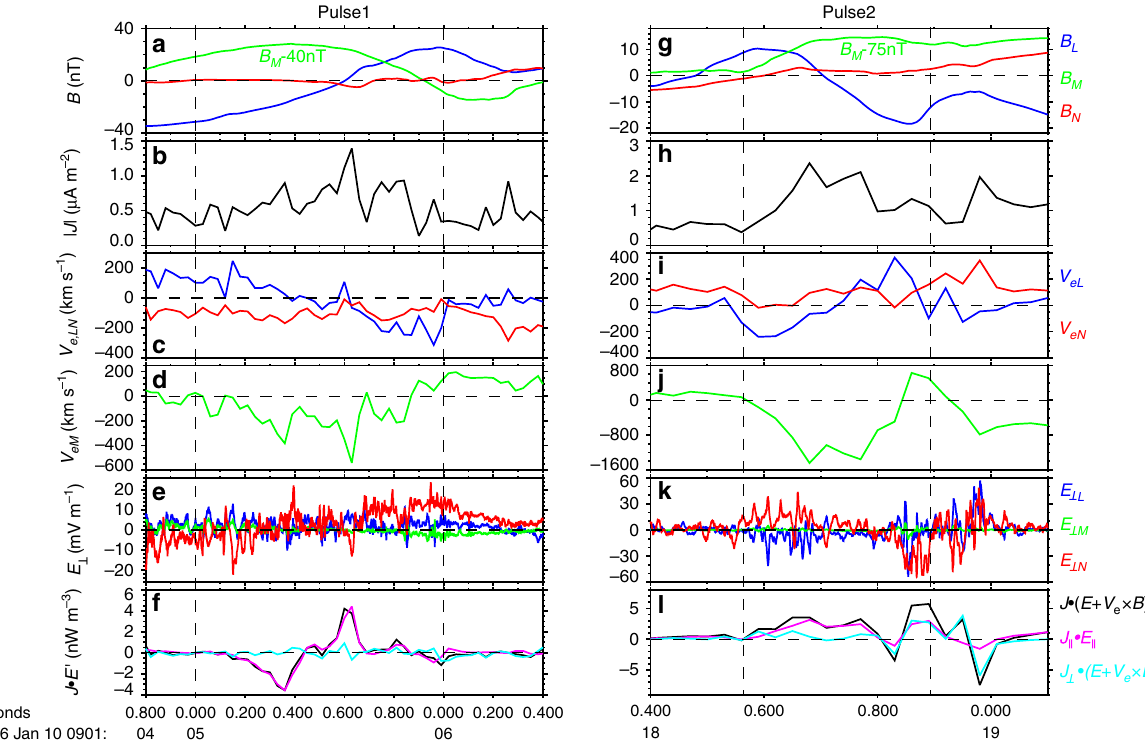
Fig. 4 Direct evidence of the reconnection in Pulse1 and Pulse2. The data are shown in a local current (LMN) coordinate with L = (0.88, − 0.47, − 0.01) M = (0.25, 0.50, − 0.83) N = (0.39, 0.73, 0.56) L = ( − 0.92, 0.05, 0.39) M = ( − 0.18, 0.82, − 0.55) N = GSE , GSE and GSE for Pulse1, and GSE , GSE , and ( − 0.35, − 0.57, − 0.74) GSE for Pulse2. a , g Magnetic fi eld B LMN , with B M shifted by − 40 nT for Pulse1 and − 75 nT for Pulse2. b , h The total current density intensity. c , i Electron velocity V e,LN . d , j Electron velocity V eM . e , k Perpendicular electric fi eld E ⊥ LMN in the spacecraft frame. The perpendicular electric